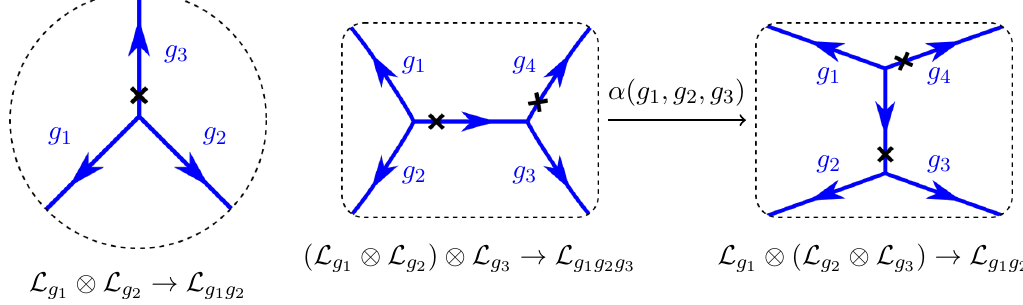
Figure 2 . The fusion of symmetry lines can be depicted as a vertex with fixed ordering of the outgoing legs while the ’t Hooft anomaly manifests itself as a non-trivial phase in a crossing relation.